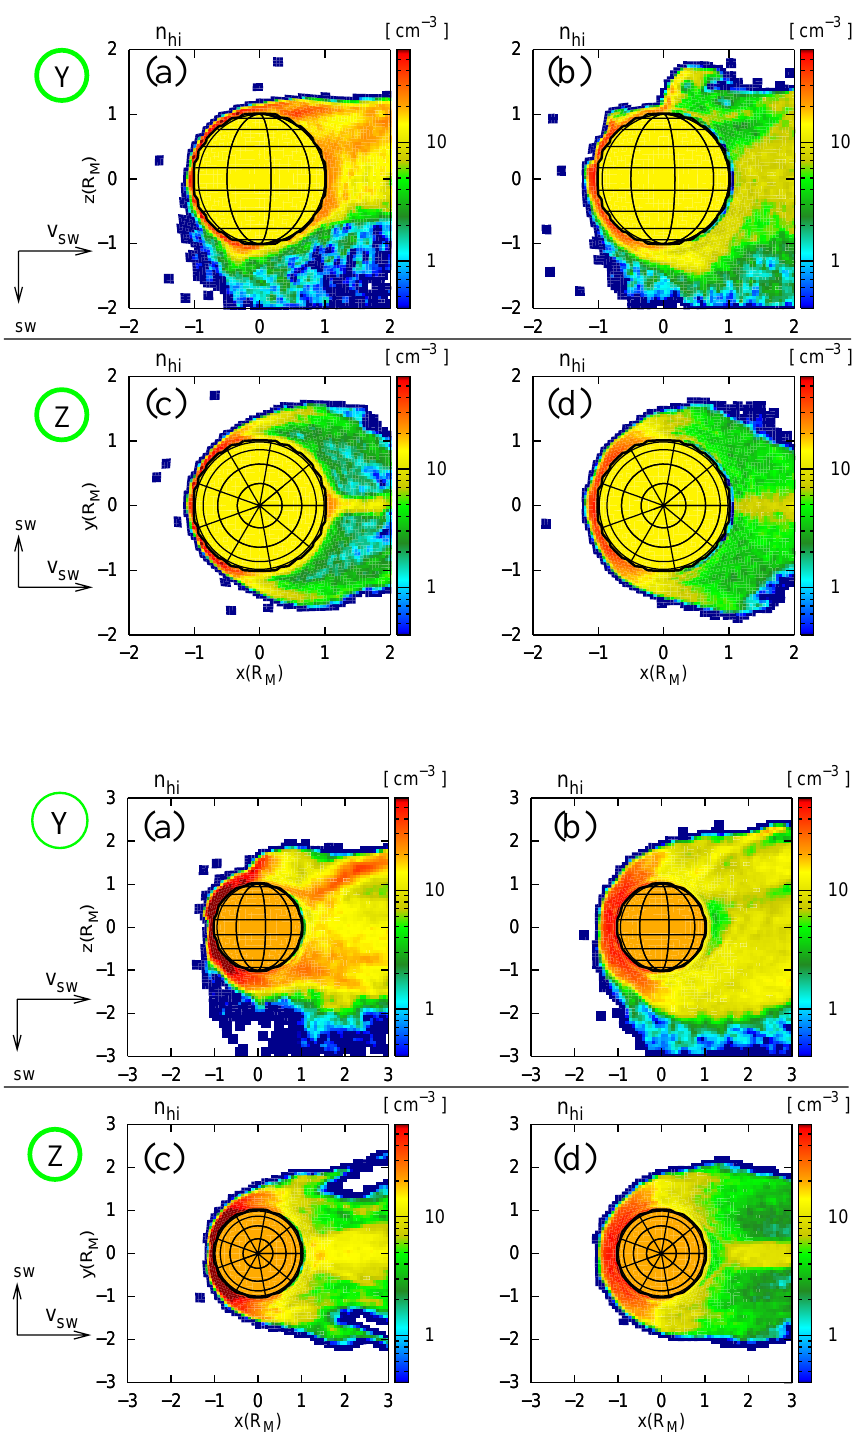
Fig. 16. Heavy ion distribution around Mars for two different solar wind den- sities. (a) and (c) n sw = 4cm − 3 (stan- dard run parameter). (b) and (d) n sw = 2cm − 3 . The ICB shifts outward with decreasing solar wind density. De- creasing the density of the solar wind is equivalent to increasing the production rate of the heavy ions. This figure, to- gether with Fig. 15, shows that the ther- mal electron pressure n e k B T e , h inside the ionosphere is the crucial parameter for the location of the ICB. Parameters: t = 835s, ν = 2 · 10 − 7 s − 1 , T e , h = 2 · 10 4